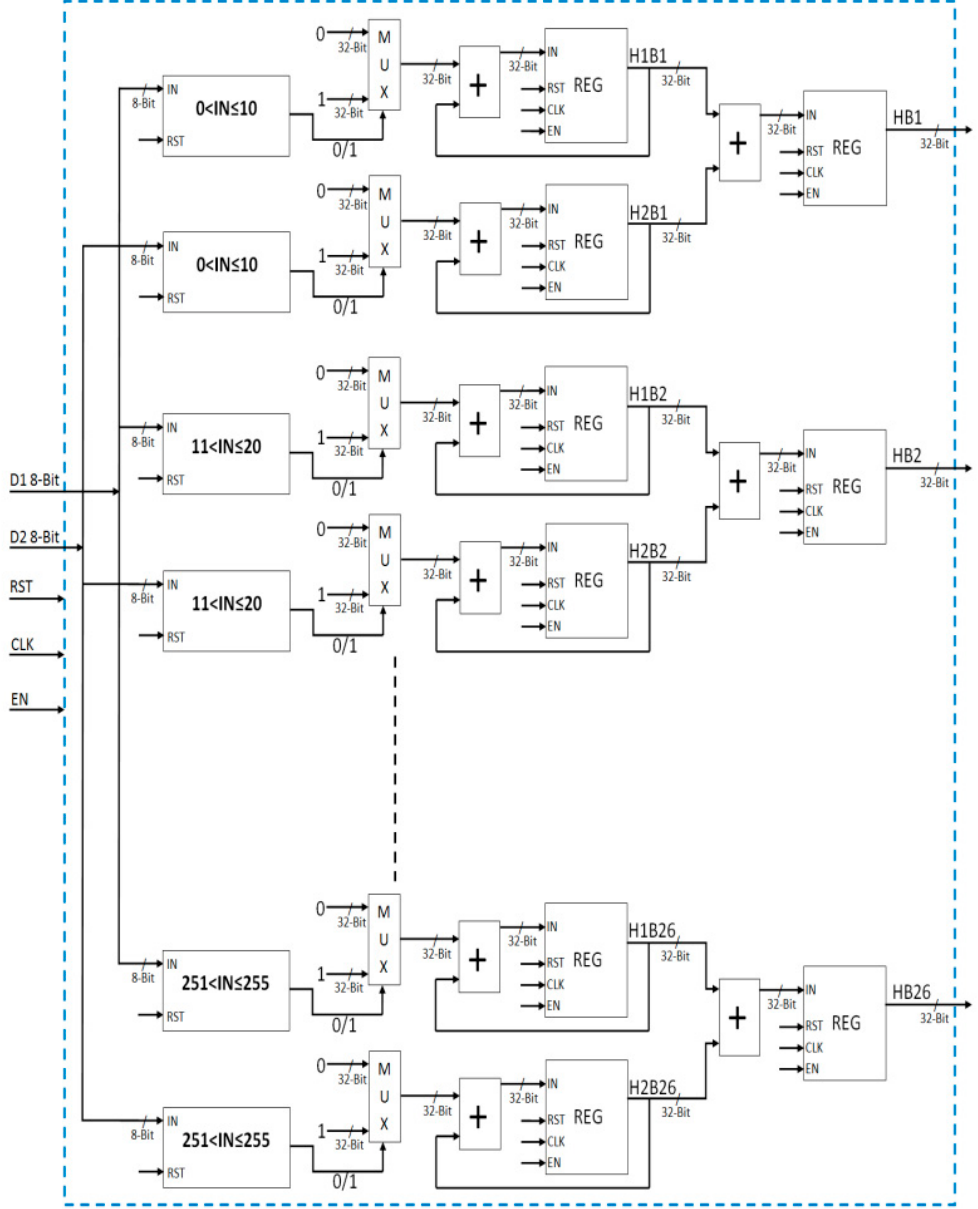
Figure 7. Architecture of histogram computation unit. D1 → Data1; D2 → Data2; RST → Reset; CLK